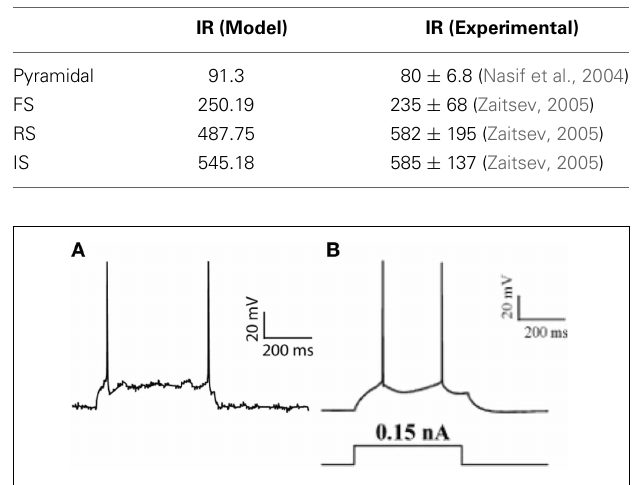
Table 1 | Input resistance values of the model neurons and those obtained from electrophysiological data.